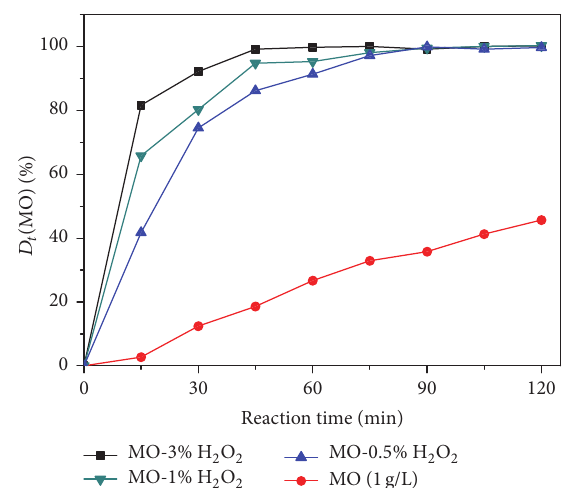
Figure 7: Variation of 𝐷 𝑡 (MO)s with MO solution (0.1g/L) in different concentration of H 2 O 2 solution under 254 nm at RT.